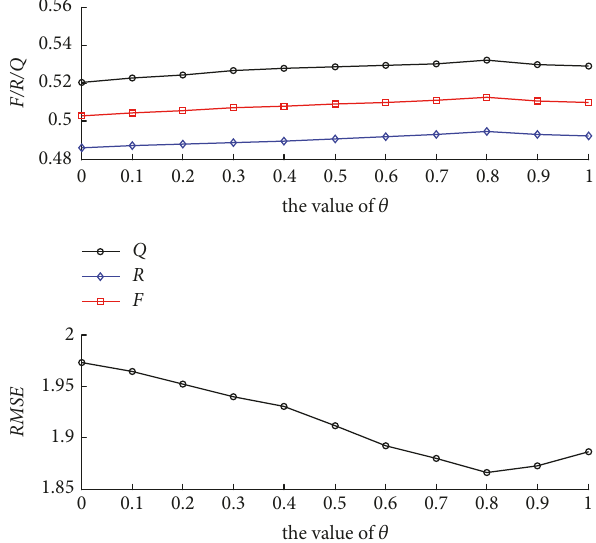
Figure 3: The comparison of the obtained results when 𝜃 is set to different values.